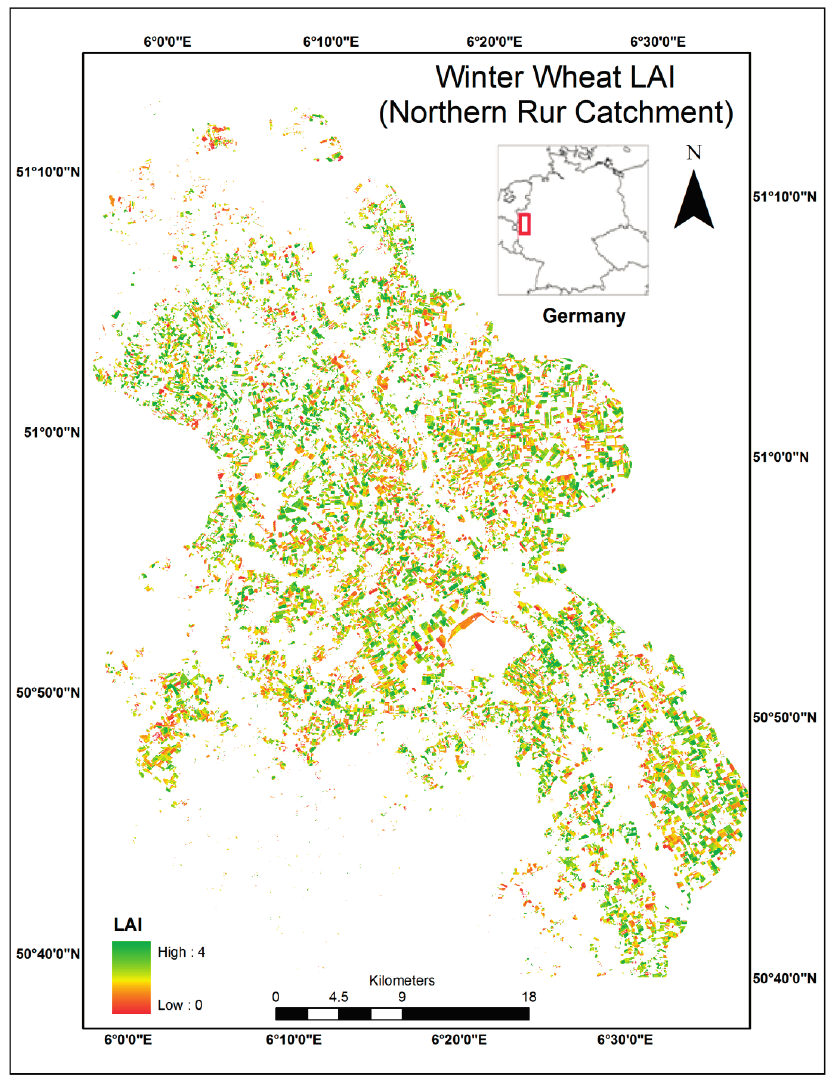
Figure 9. Winter wheat LAI NDRE map of the northern Rur Catchment for 2 April